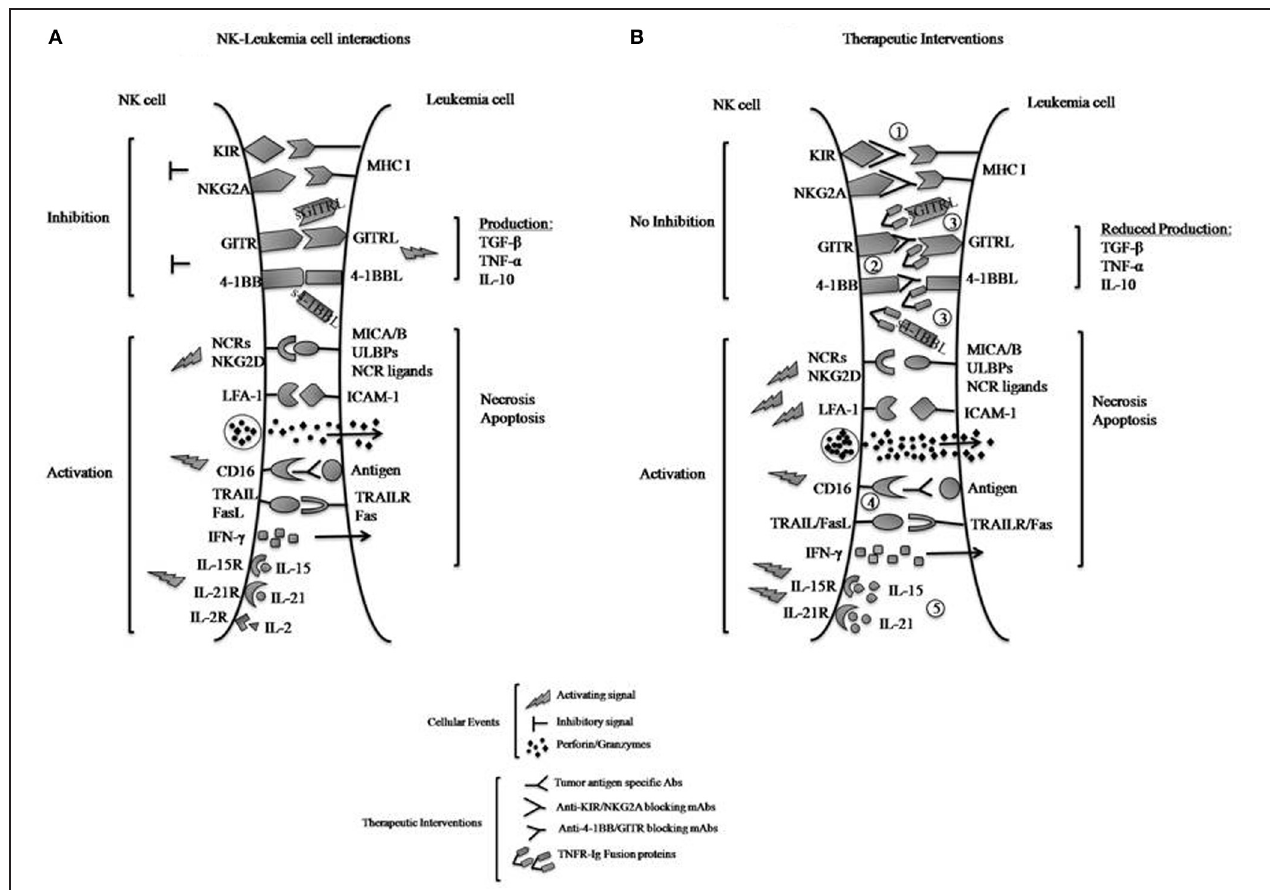
FIGURE 1 | (A) Interactions of inhibitory and activating NK cell receptors, including TNF family receptors 4-1BB and GITR, with ligands expressed on leukemia cells. Engagement of the inhibitory receptors KIR and NKG2A with MHC class I molecules directly transmits inhibitory signals to the NK cells to reduce killing of tumors and IFN- γ production, whereas interactions of 4-1BB with 4-1BBL and GITR with GITRL can produce activating or inhibitory effects depending on conditions. Here their exclusively inhibitory effects upon interaction with leukemia cells are illustrated. Reverse signaling (by the bound ligands 4-1BBL and GITRL) to signal the leukemia cells induces the leukemic production of immunosuppressive cytokines such as TGF- β , TNF- α , and IL-10, which also suppress NK cell functions. Engagement of the activating NK cell receptors (NCRs) to their respective ligands and NKG2D to MICA/B or ULBPs on tumors transmits activating signals to NK cells and triggers their functions. Interactions between